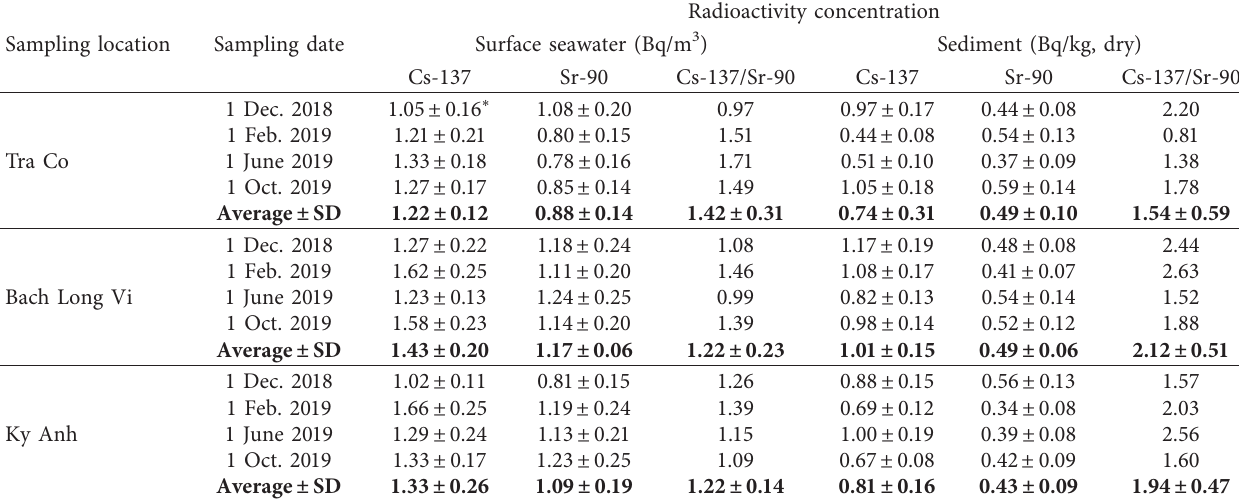
Table 2: Radioactivity concentrations of Sr-90 and Cs-137 in surface seawater and sediment in the Gulf of Tonkin. Sampling location